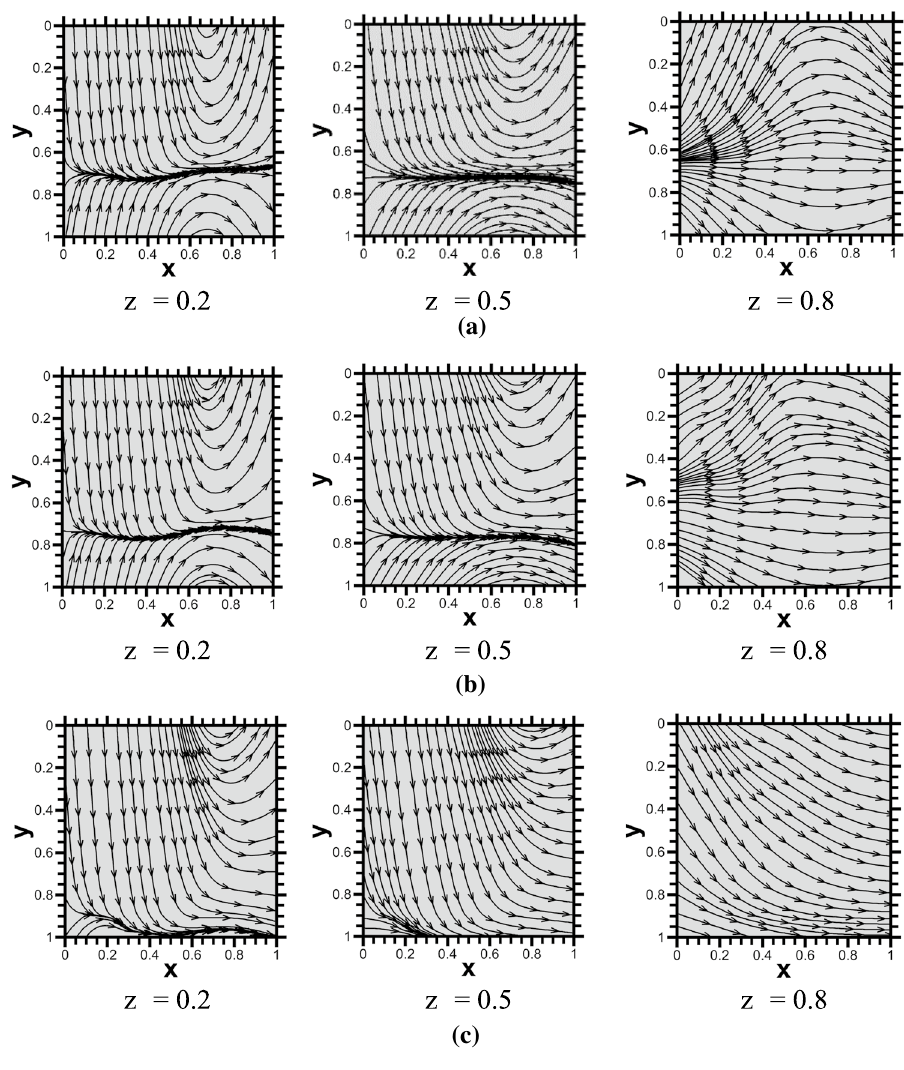
Fig. 14 A sample of the stream lines in the longitudinal section for passing plates through the 𝜐 width ( = 0.05) a t = 0.05, b t = 0.1, c t =